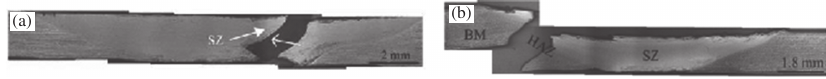
Figure 8: Fracture location of different thick joints: (a) 2mm and (b) 1.8mm.